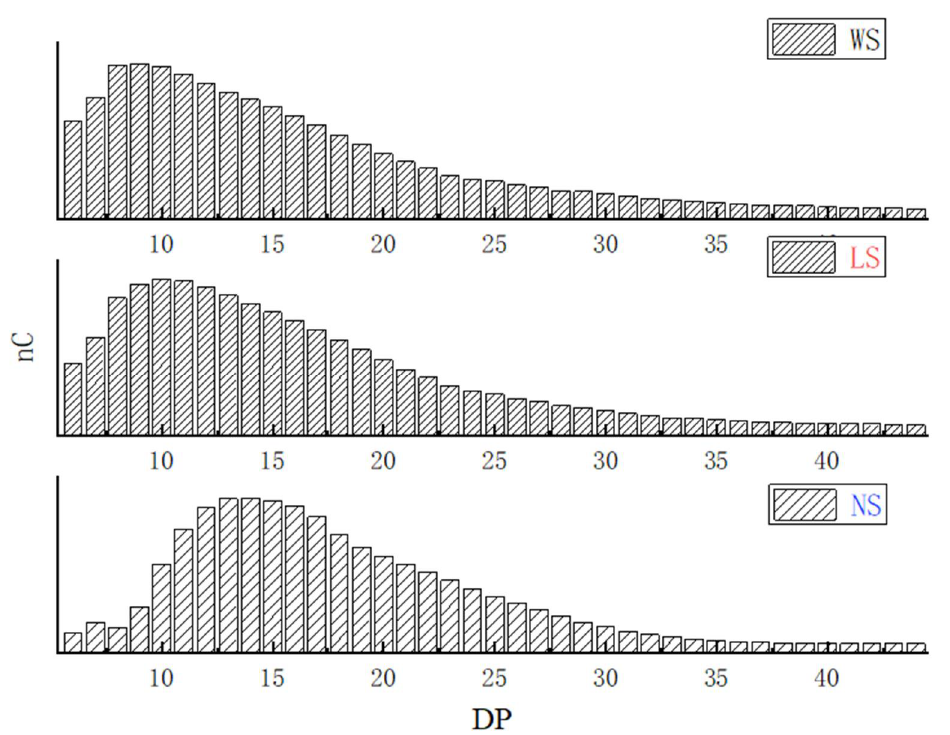
Figure 2. Amylopectin chain length distribution of starch samples extracted by different methods.